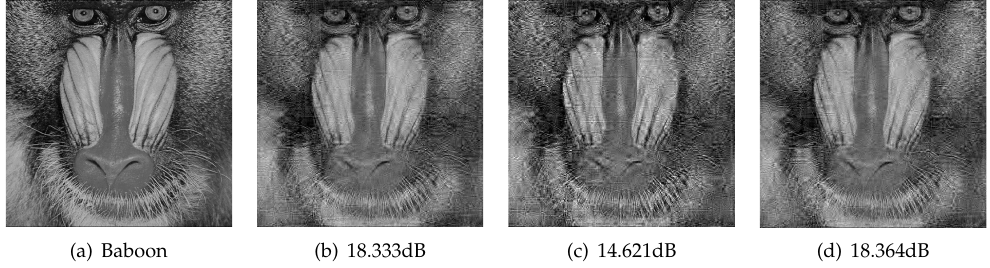
Figure 13. The reconstruction results of the standard test image Baboon at τ = 0.4. ( a ) original image; ( b ) reconstructed by HTP with α ∗ = 4, (PSNR: 18.333 dB); ( c ) reconstructed by CGIHT (PSNR: 14.621 dB); ( d ) reconstructed by CGHTP (PSNR: 18.364